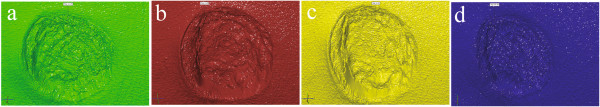
Laser scanning images of the same pressure sore. Image-processed scans of a treated pressure sore (a) after treatment and at (b) 5 days, (c) 12 days, and (d) 19 days.